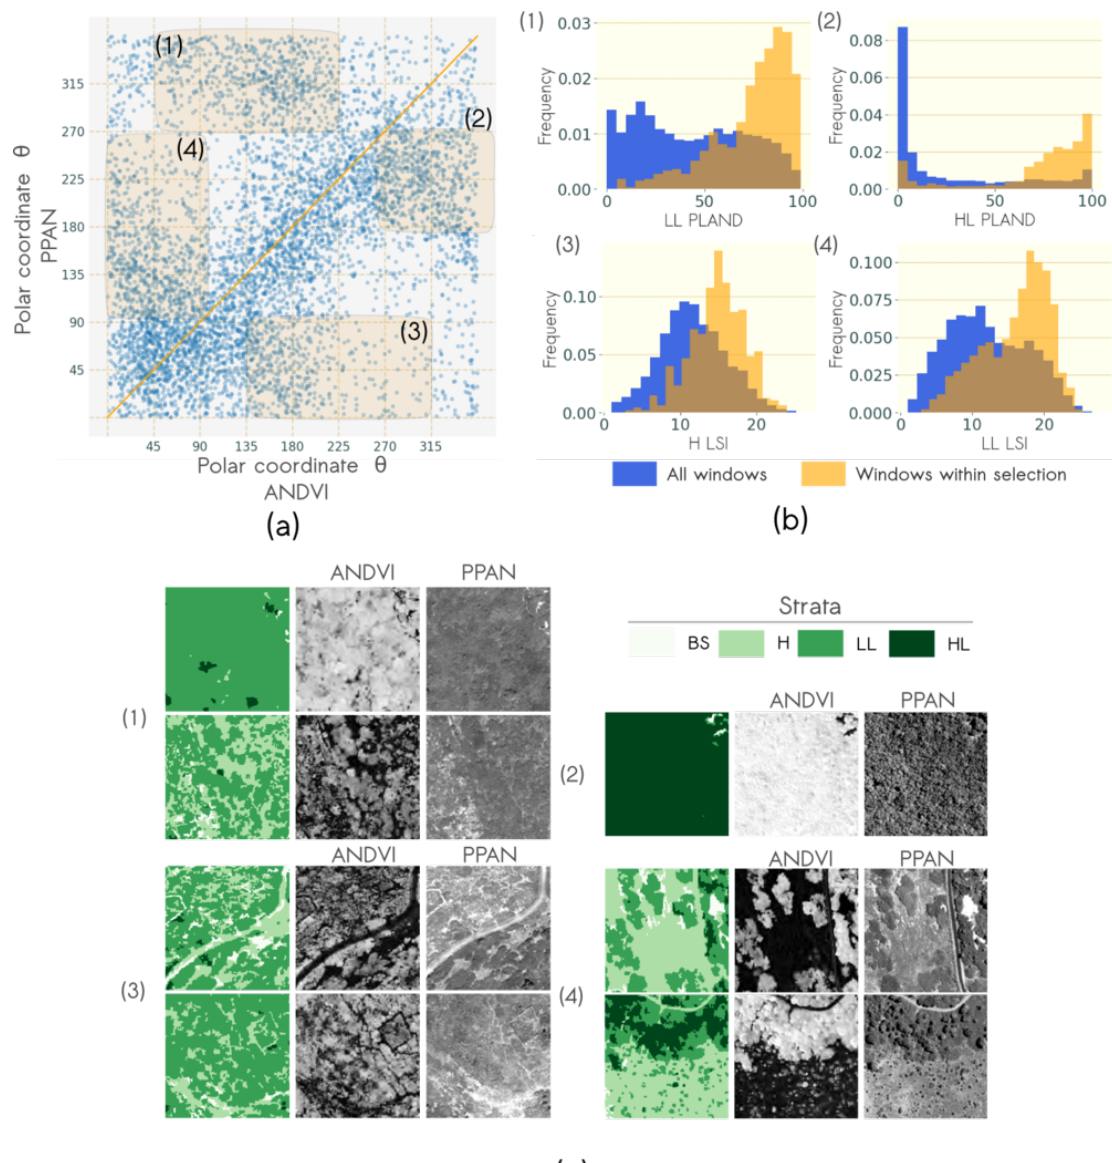
Figure 11. Co-variation of texture gradients derived from airborne imagery NDVI and Pléiades panchromatic band: ( a ) Scatterplot of angular coordinates with four types of angular variations highlighted in orange: (1) from [45 ◦ , 225 ◦ ] to [270 ◦ , 360 ◦ ], (2) from [270 ◦ , 360 ◦ ] to [180 ◦ , 270 ◦ ], (3) from [135 ◦ , 315 ◦ ] to [0 ◦ , 90 ◦ ] and (4) from [0 ◦ , 90 ◦ ] to [135 ◦ to 270 ◦ ]; ( b ) typical windows of each variation type and ( c ) histograms of characteristic vegetation structure of each angular variation type, metric distribution is plotted in blue when considering all windows and in orange when considering only windows within the variation type angular range